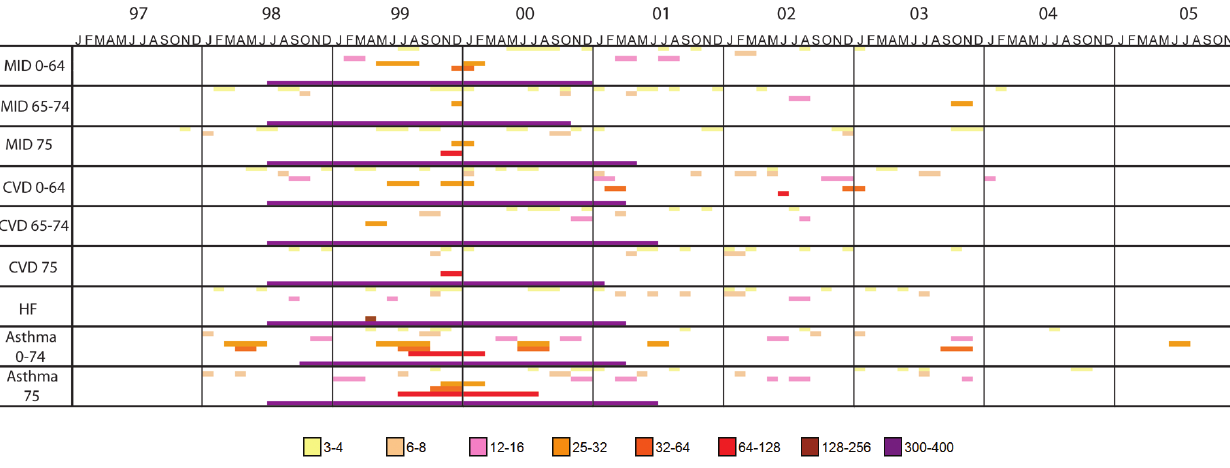
Fig. 4. Cross wavelet and wavelet coherence coincident time periods by band for sunspots and all diseases. half year periodicity (128–256 days band) around 1999 for all of the diseases except for MID 65–74 and CVD ≥ 75. The behaviour of the high frequency content for cross wavelet and wavelet coherence coincidence periods is not so evident. However, for sunspots there are few or none coincidences during 1997, 2004 and